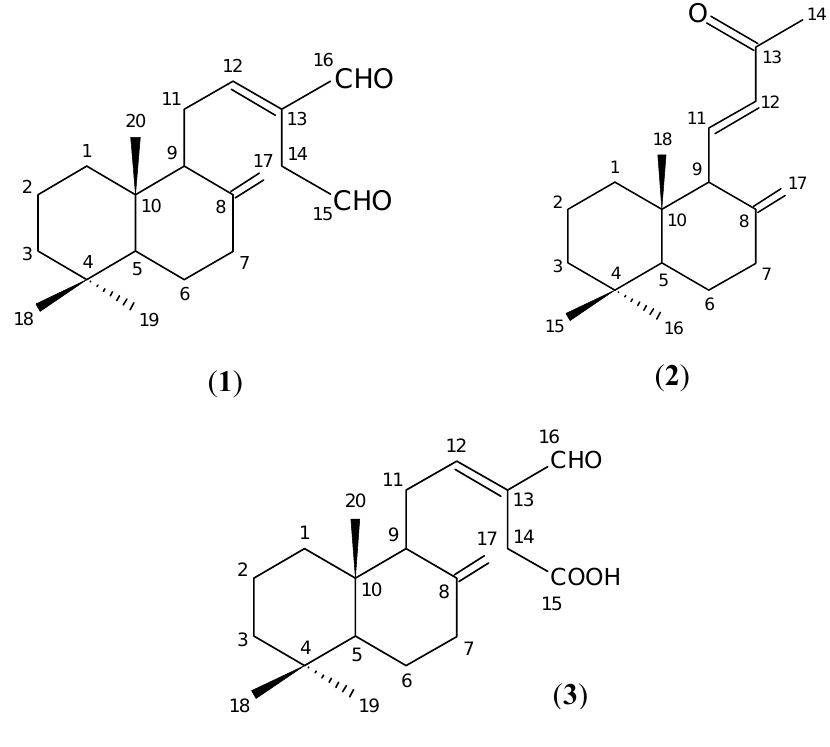
Figure 1. Chemical structures of compounds 1-3